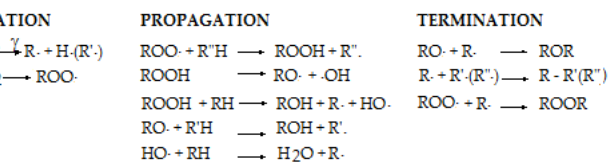
Figure 1. Scheme of oxidative degradation of irradiated polymers, the major component of